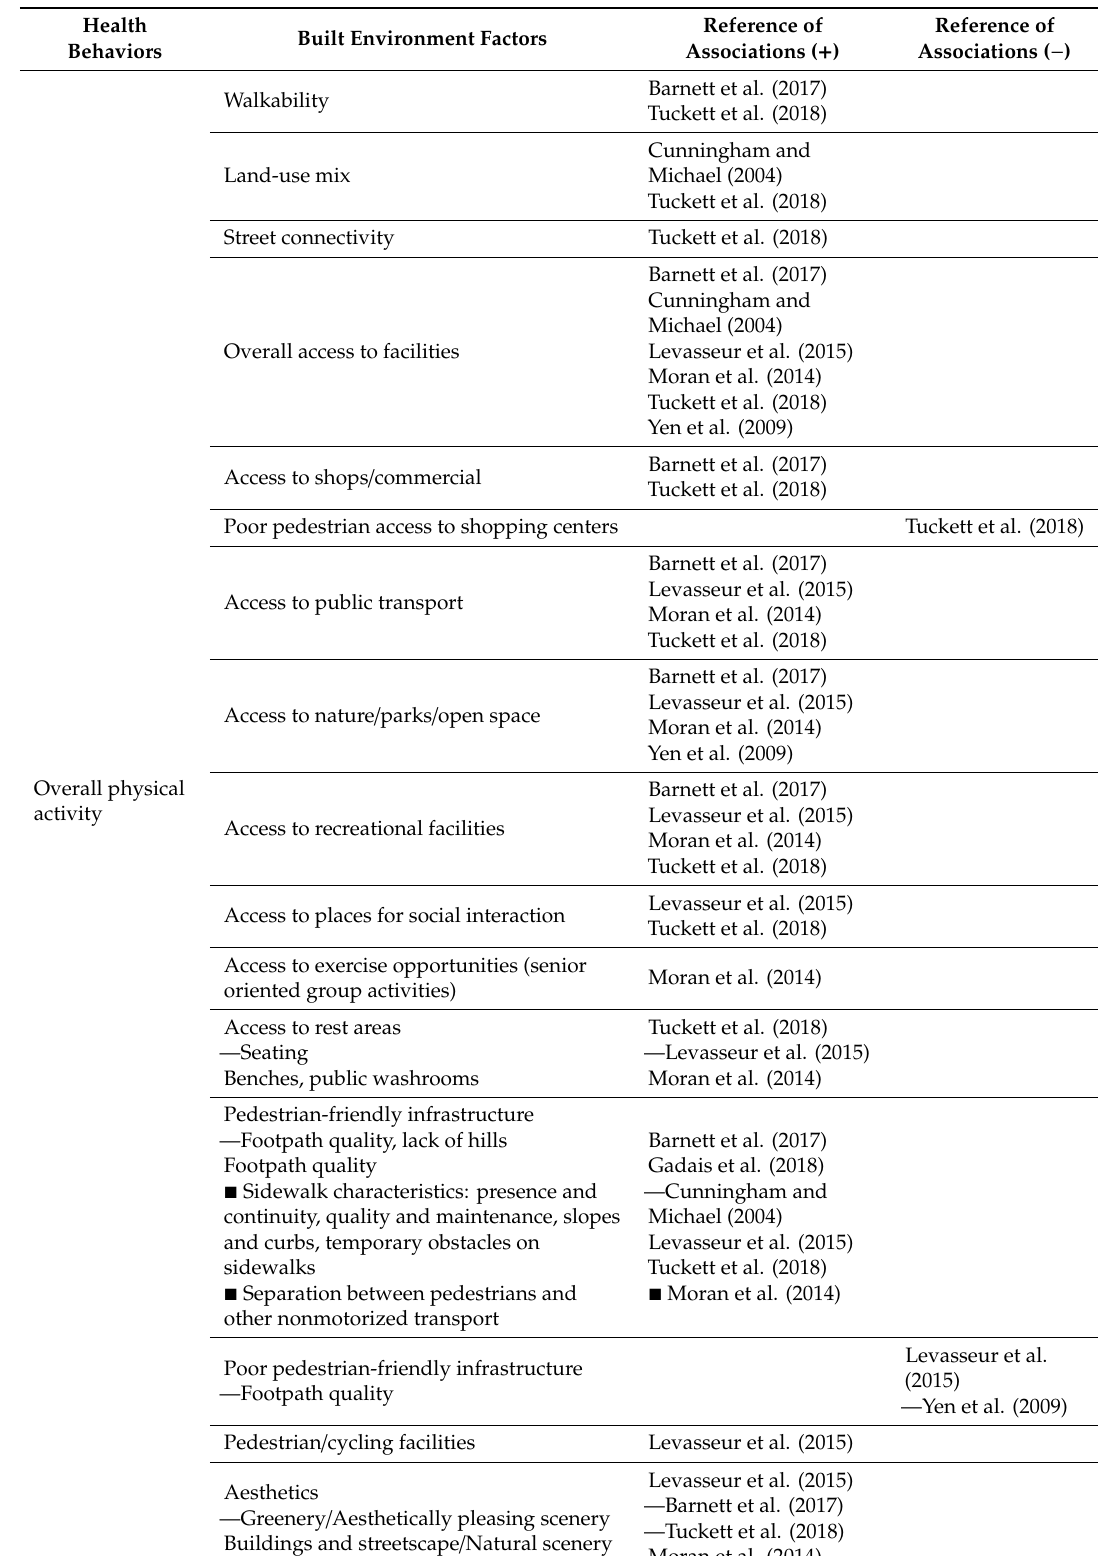
Table 3. Summary table with the associations between the elements of the built environment and the types of physical